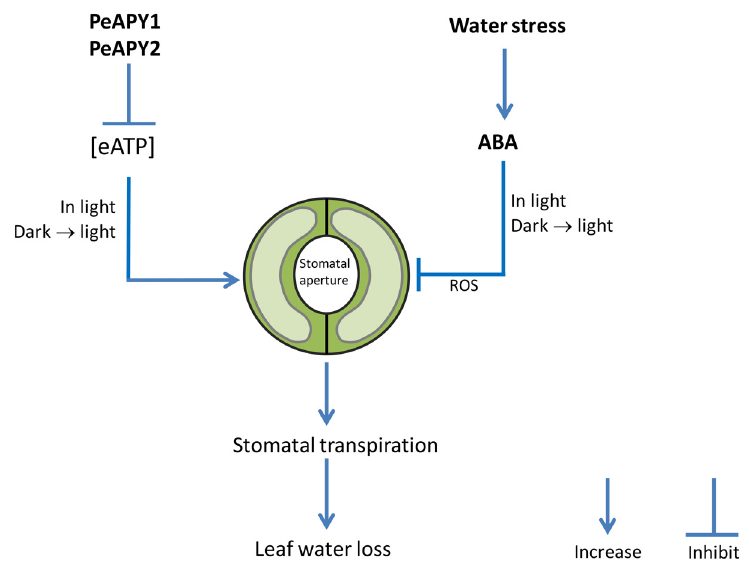
Figure 8. A schematic model showing that Populus euphratica apyrases increase stomatal sensitivity to ABA in